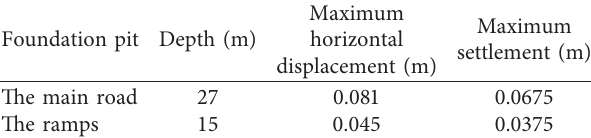
Table 2: The control requirements of foundation pit deformation. Foundation pit Depth